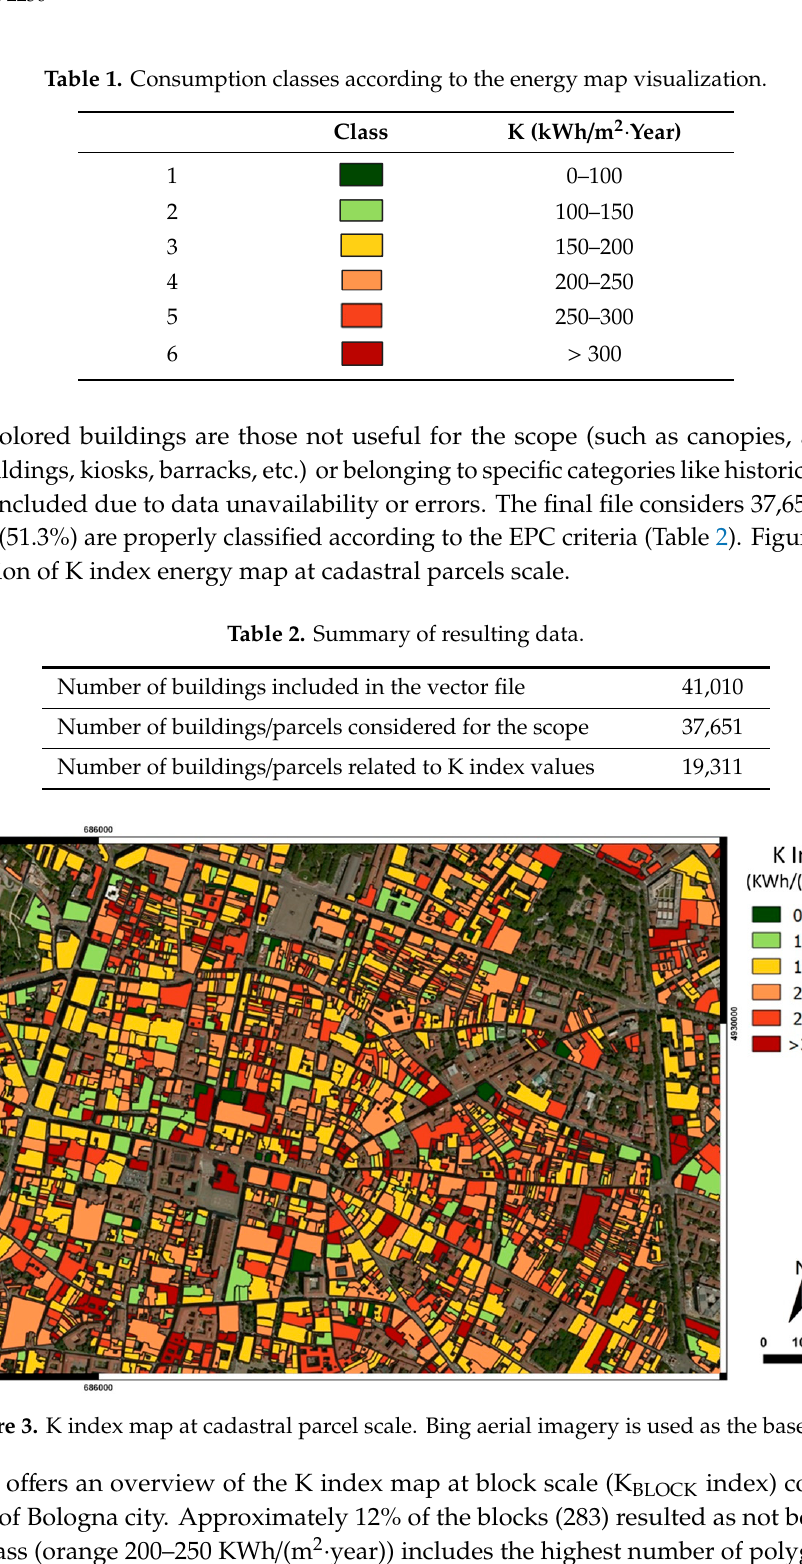
Table 2. Summary of resulting data.